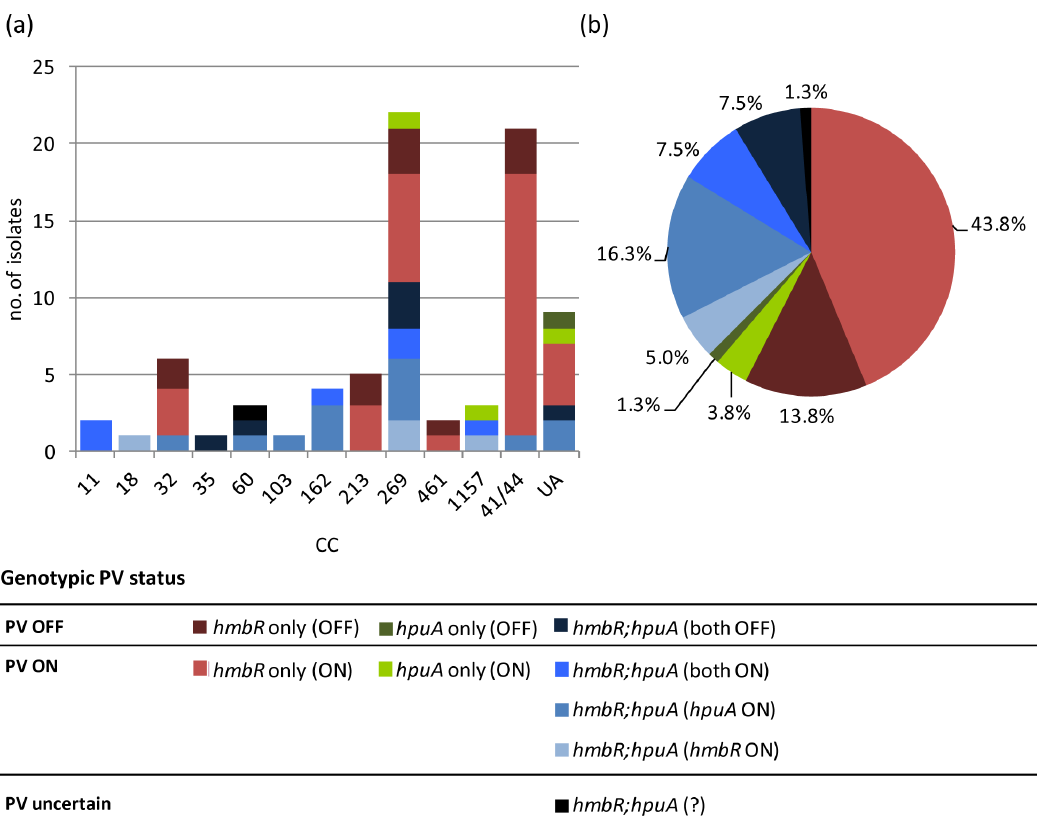
Figure 5. Distribution of genotypic phase variable expression status of hmbR:hpuA genotypes among a representative panel of English, Welsh and Northern Irish invasive serogroup B meningococcal isolates collected from 2008–2011. This figure shows the number (a) or percentage (b) of isolates with particular combinations of PV expression states. In graph (a), there is further separation based on clonal complex. UA= unassigned STs. hmbR only = isolates that possess hmbR but not hpuA. hpuA only = isolates that possess hpuA but not hmbR . hmbR:hpuA = isolates that possess both hmbR and hpuA .